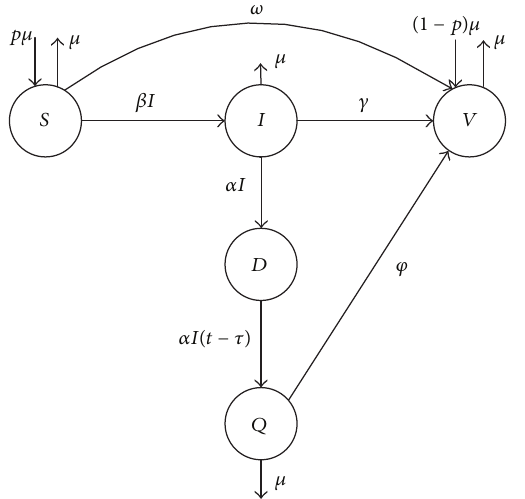
Table 1: Notations in this